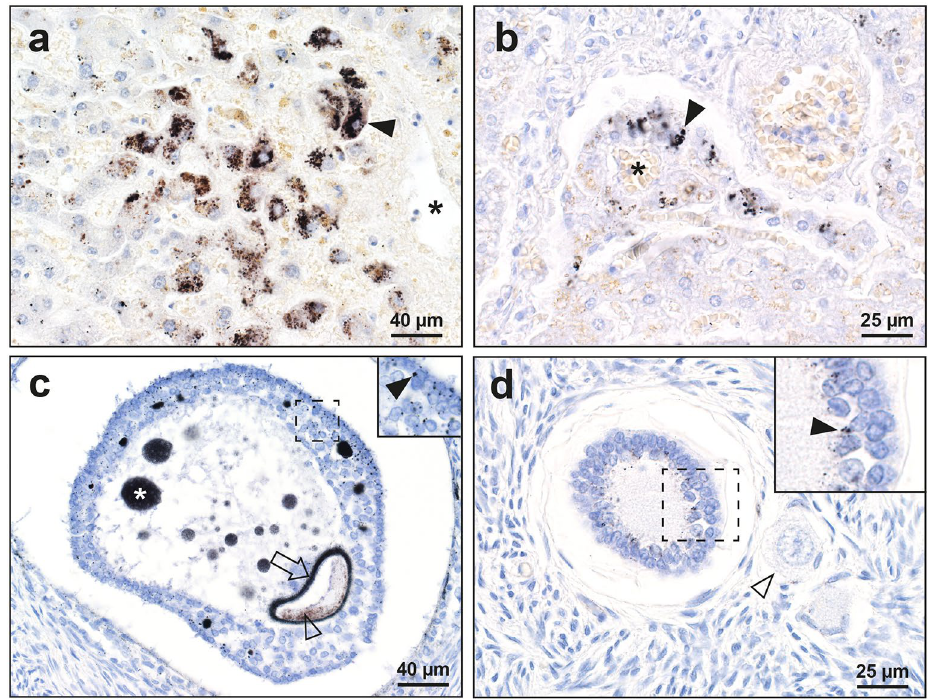
Figure 2. Autometallography of organs occasionally containing mercury. Right upper insets are magnified regions of dashed rectangles. ( a ) In the liver, hepatocytes (arrowhead) adjacent to a hepatic venule (asterisk) contain black iHg granules. ( b ) In this liver, iHg granules are present in portal tract cells (arrowhead) surrounding the portal vein (asterisk). ( c ) In an ovarian follicle iHg is seen in the zona pellucida (arrow) and cytoplasm (open arrowhead) of the ovum, as well as attached to the nuclei of granulosa cells (closed arrowhead) and in round profiles (asterisk) in the antrum. ( d ) Granulosa cells of an ovarian follicle contain small iHg grains (closed arrowhead). An adjacent primary oocyte (open arrowhead) does not contain iHg. Autometallography/